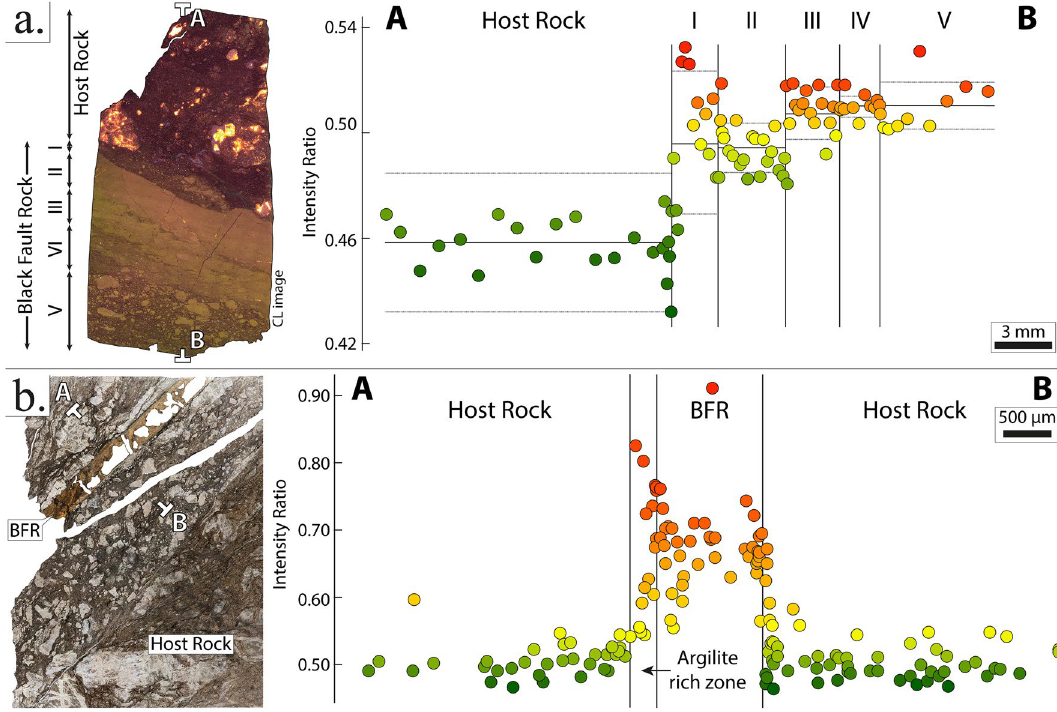
Figure 5. Raman spectroscopy intensity ratio and microstructures of the Kodiak ( a ) and Nobeoka Black Fault Rocks ( b ) and their host rocks. Note that in ( b ), the Black Fault Rock is composed of several layers labelled I to